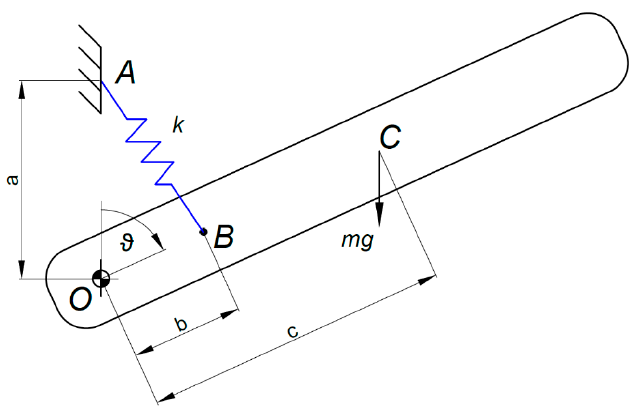
Figure 1. Single DOF link with balancing zero free-length spring.